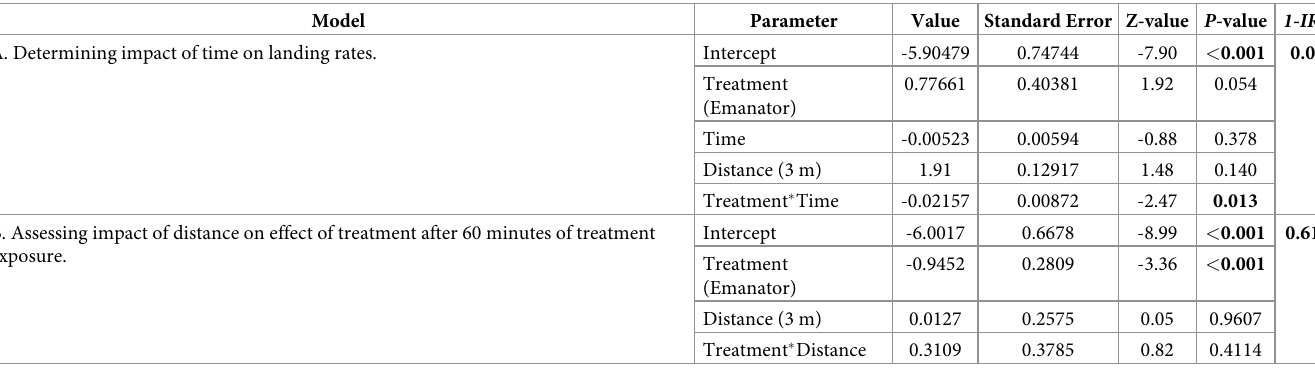
Table 4. IRR estimates from a GLMM Model of mosquito landing counts upon exposure to metofluthrin emanators at different distances